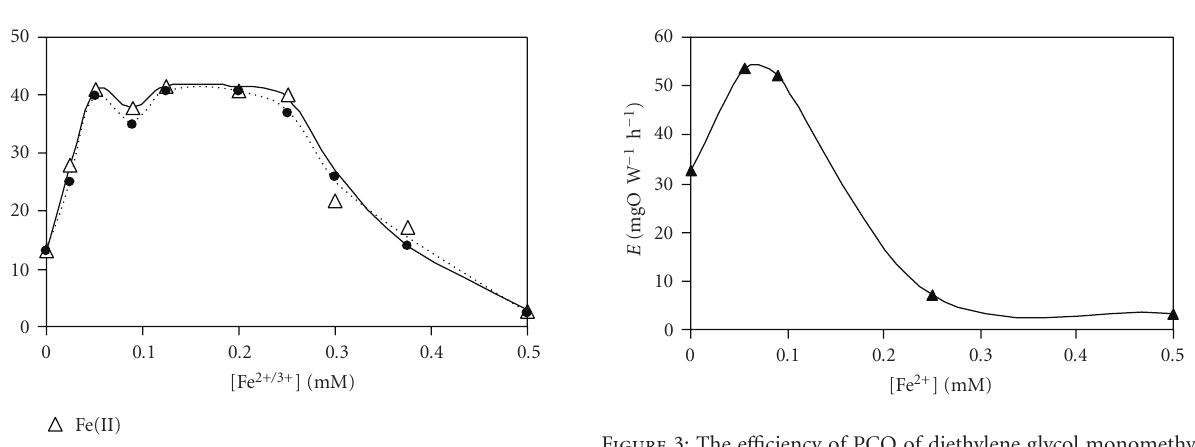
Figure 3: The e ffi ciency of PCO of diethylene glycol monomethyl ether (DEGMME) in TiO 2 suspension versus concentration of Fe 2+ - ions at pH